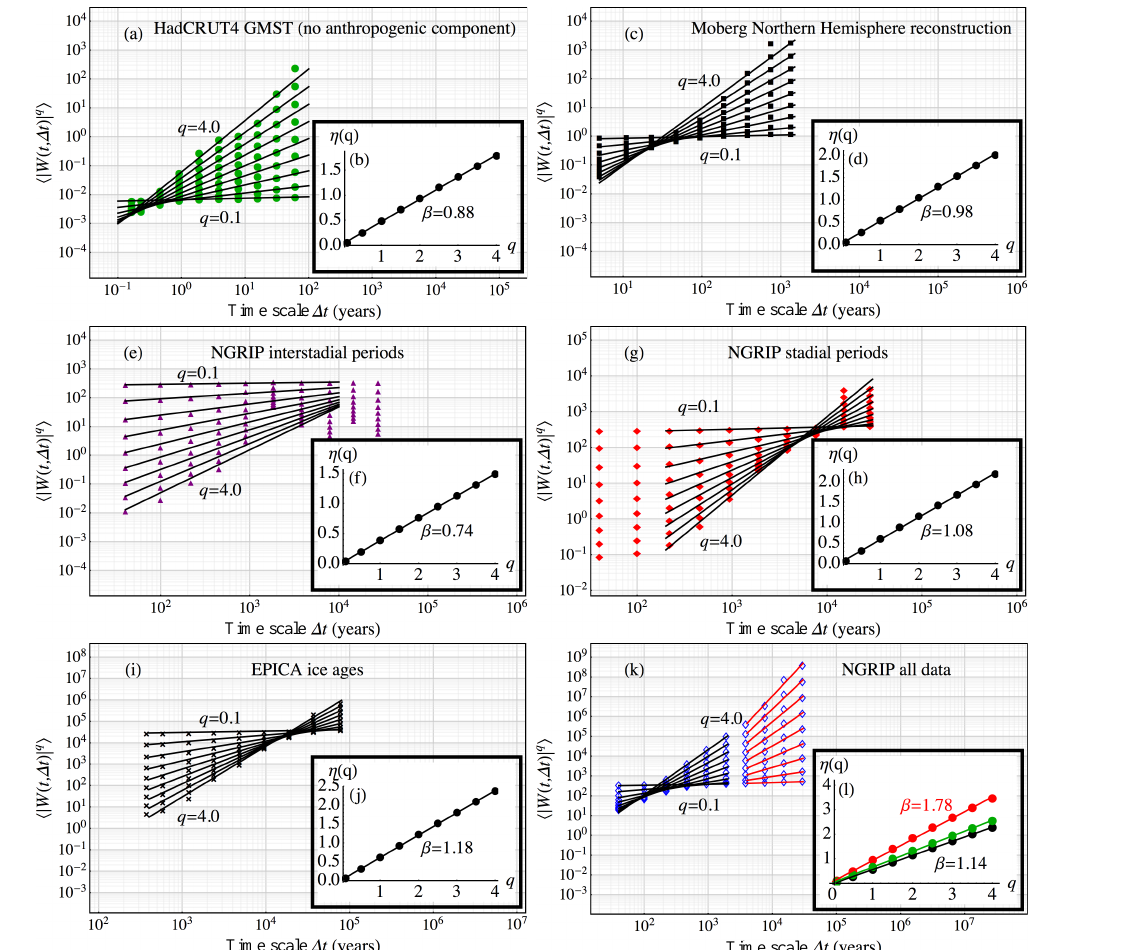
Figure 4. (a) The estimated wavelet-based structure functions (cid:104)| W ( t,(cid:49)t ) | q (cid:105) for the HadCRUT4 monthly global mean surface tempera- ture where the anthropogenic component has been removed using a linear-response model. The lines show the fitted power-law functions c q (cid:49)t τ ( q ) . The q values are q = 0 . 1 , 1 . 0 , 1 . 5 ,..., 4 . 0. (b) The scaling function τ ( q ) obtained from the fitted power laws in (a) . The line is a linear fit to the estimated scaling function, and the slope of this line is β/ 2 with β = 0 . 88. (c–d) As (a) and (b) but in this case for the Moberg Northern Hemisphere reconstruction. (e–f) As (a) and (b) but for the interstadial periods in the NGRIP record. (g–h) As (a) and (b) but for the stadial periods in the NGRIP record. (i–j) As (a) and (b) but for the ice age periods in the EPICA record. (k–l) As (a) and (b) but for the NGRIP record including both stadial and interstadial periods. The red curve in (l) is the scaling function estimated from the longest timescales, the blue curve is the scaling function estimated from the shortest timescales, and the green curve is the scaling function estimated using all the available